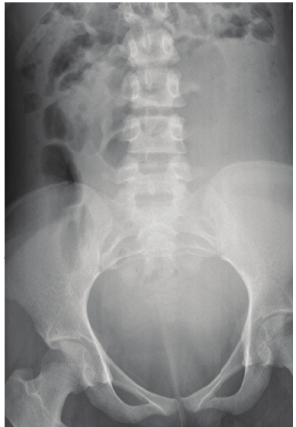
Figure 3: Abdominal radiograph demonstrating a large mass in the left lower quadrant, displacing bowel